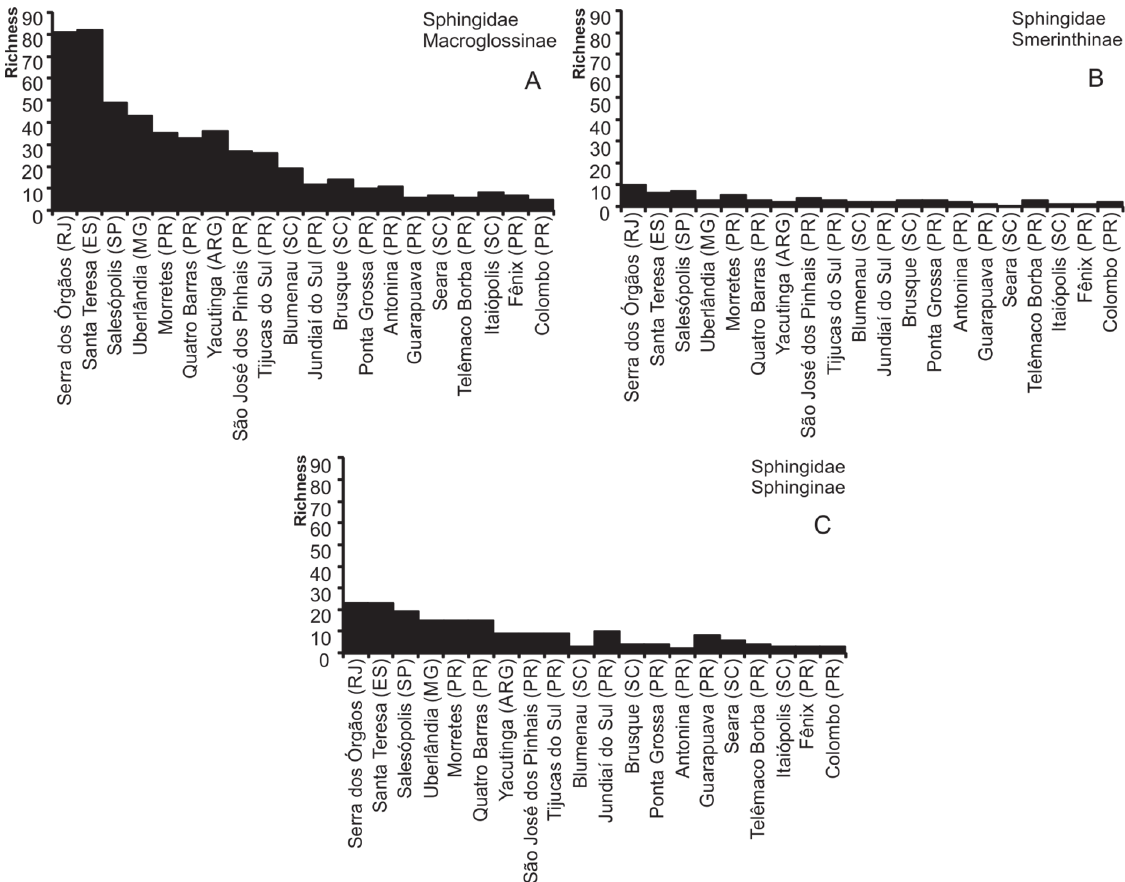
Figure 6 - Richness of the subfamilies of Sphingidae (A-C) compared between different